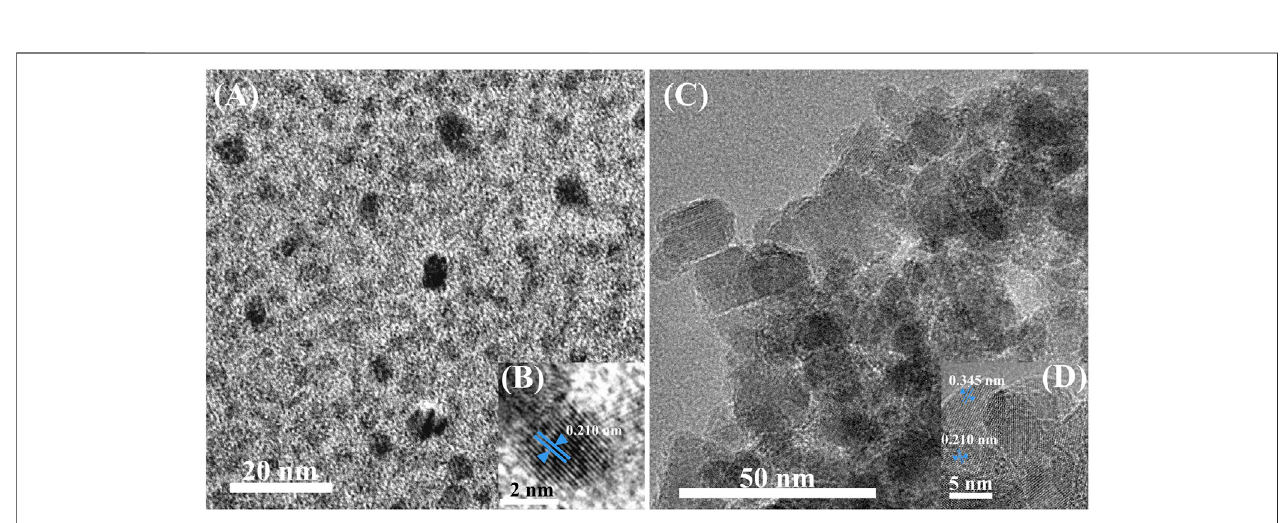
FIGURE 2 | TEM and HRTEM image of CDs (A,B) and carbon dots (CDs)-Fe 3 O 4 nanomaterial (C,D) .